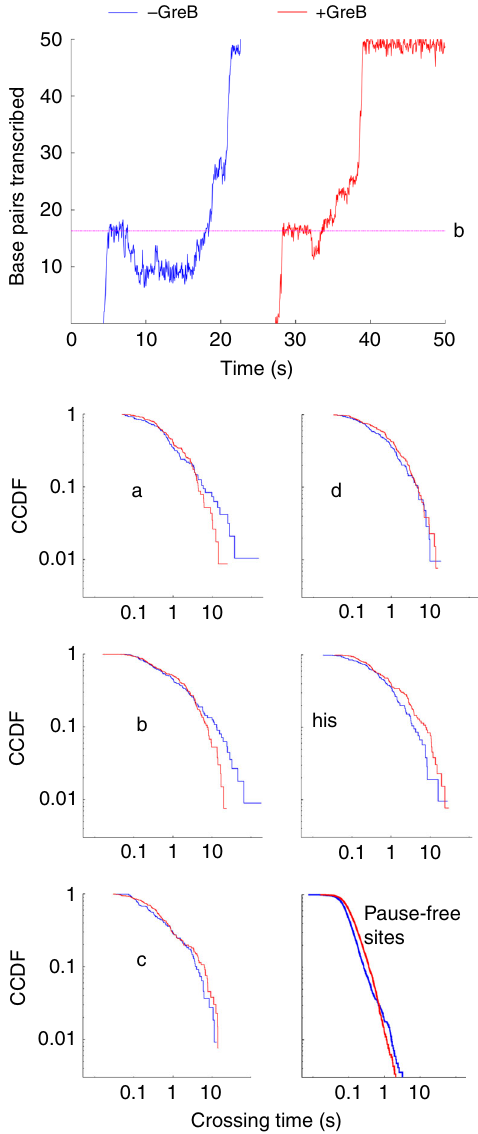
Fig. 4 Effect on 0.87 µ M GreB on transcription dynamics measured at 10 pN opposing force. Top: transcription data in the presence and absence of GreB with backtracking events at site ‘ b ’ . Bottom: effect of GreB on the crossing time distributions at the major pause sites. At short time scales, comprising 80 – 90% of the measured events, GreB slightly increases crossing times. Therefore mean residence times are longer in the presence of GreB at pause sites (Supplementary Fig. 4b). GreB reduces the crossing times at sites ‘ a ’ and ‘ b ’ for the longest events, indicating that these